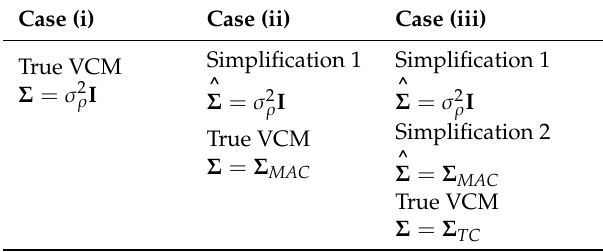
Table 1. Approximation of the variance-covariance matrix (VCM) in the least-square (LS) adjustment to estimate the B-spline surfaces for the three cases under consideration. σ 2 ρ can take the values σ 2 ρ or σ 2 ρ ,2